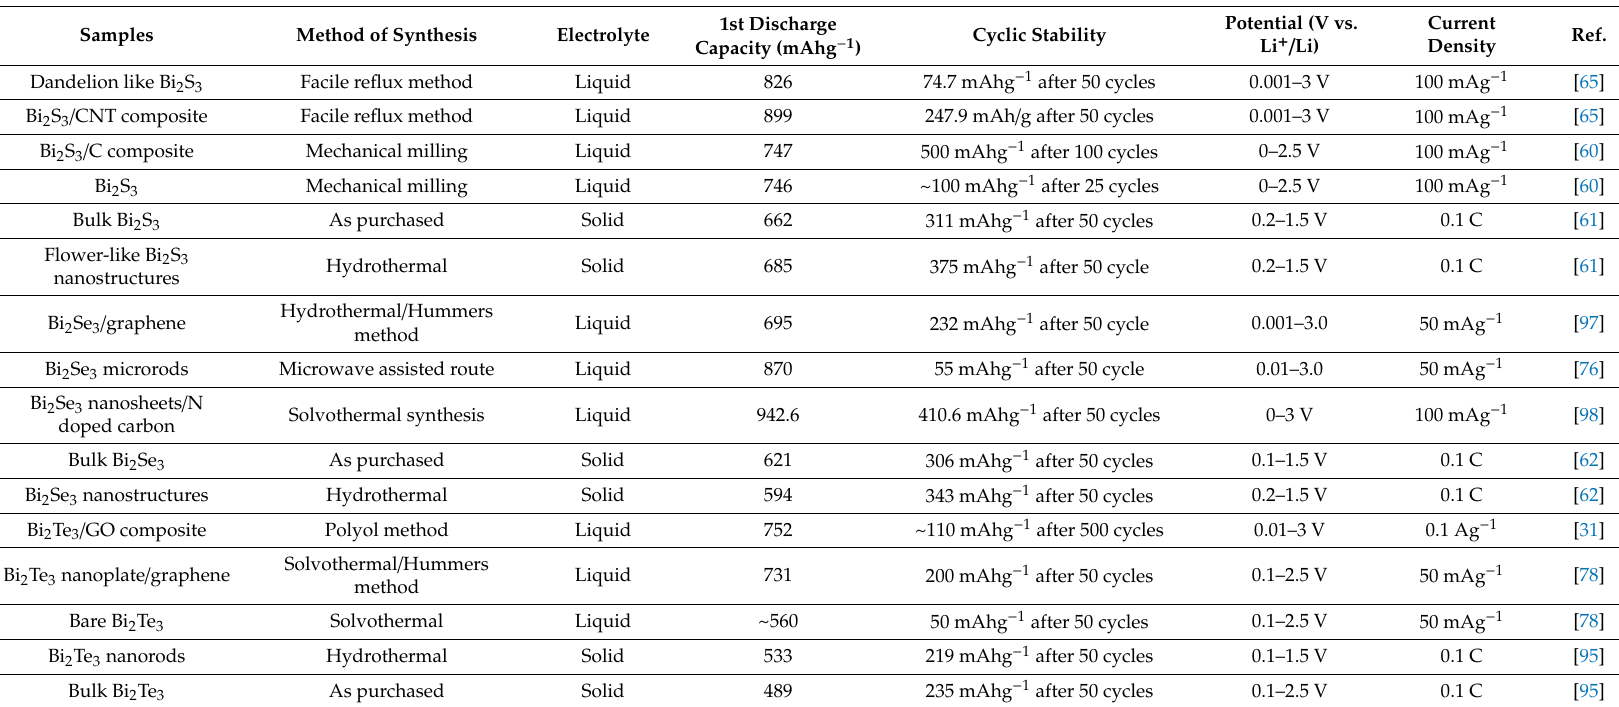
Table 1. Comparitive of discharge and cyclic capacities of di ff erent bismuth chalcogenide bulk and